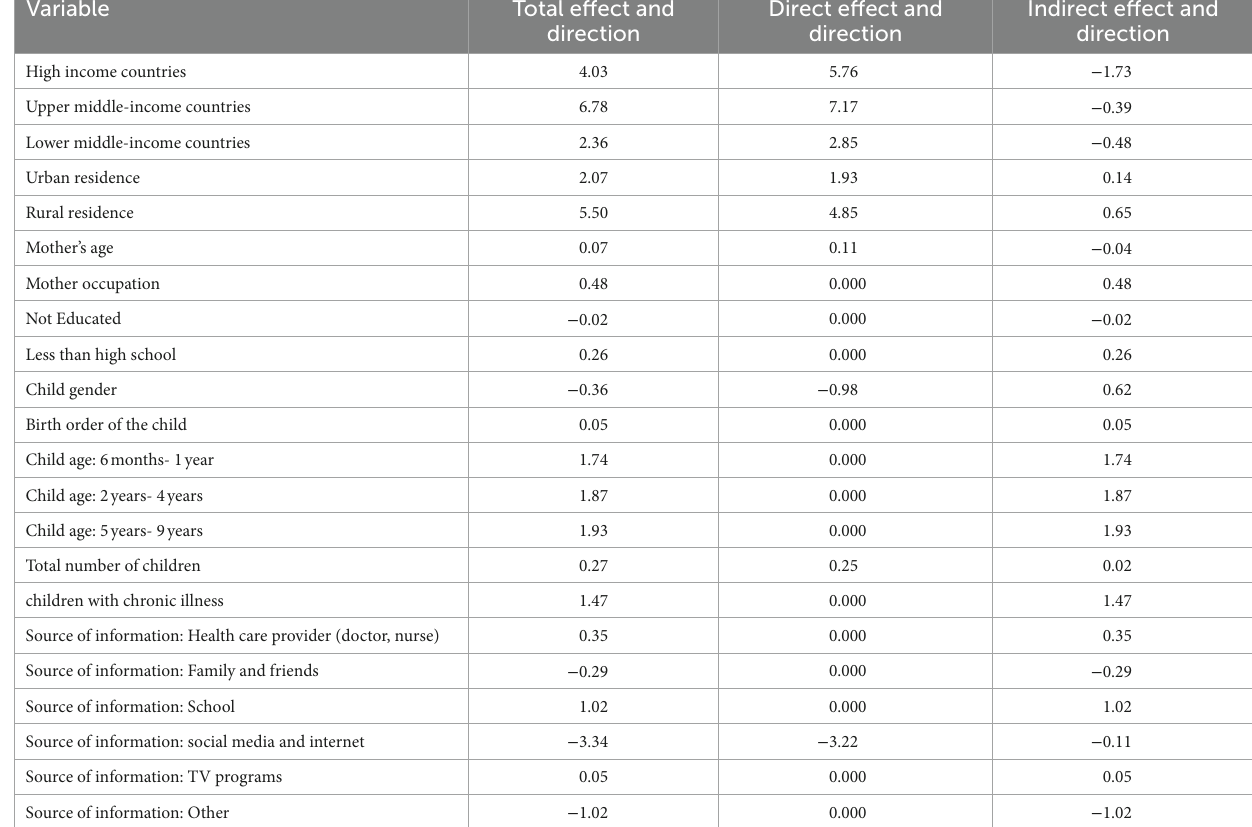
TABLE 2 Value and direction of the total, direct, and indirect effect of exogenous variables on parental attitude toward childhood influenza vaccines. Variable Total effect and